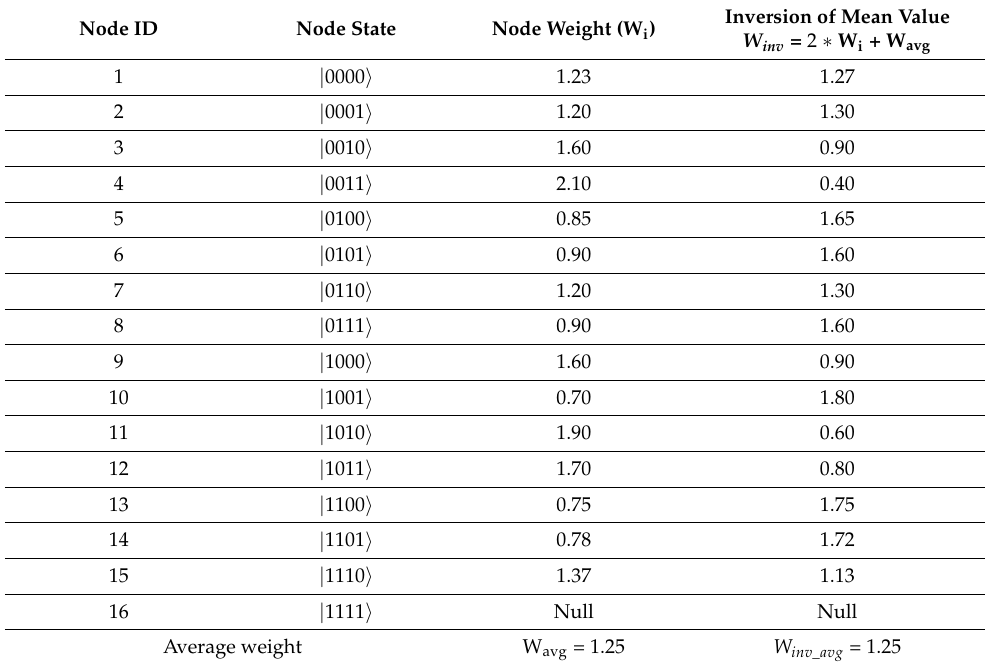
Table 3. Our quantum algorithm based on weighted target parameters, and its